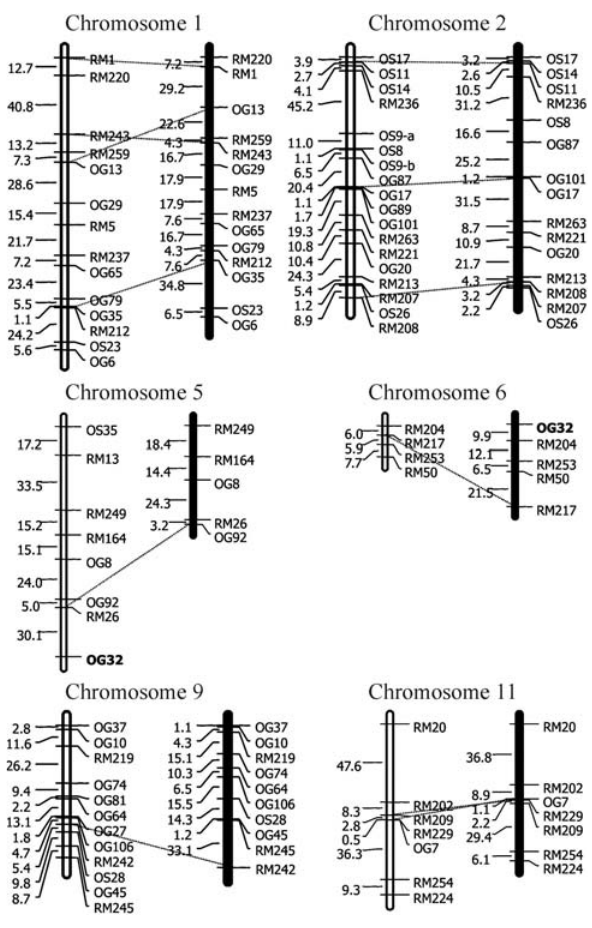
Figure 2 - Comparative map of the two populations derived from the O. glumaepatula x O. sativa crosses. The open bars are the RS-16 ( O. glumaepatula ) x Cica-8 ( O. sativa ) linkage groups and the filled bars are the RS-16 ( O. glumaepatula ) x BG90-2 ( O. sativa ) linkage groups. All markers in the groups were common to both populations. The discontinu- ous lines show the markers that had their orders inverted between the two maps. The OG32 marker that mapped to different linkage groups is in